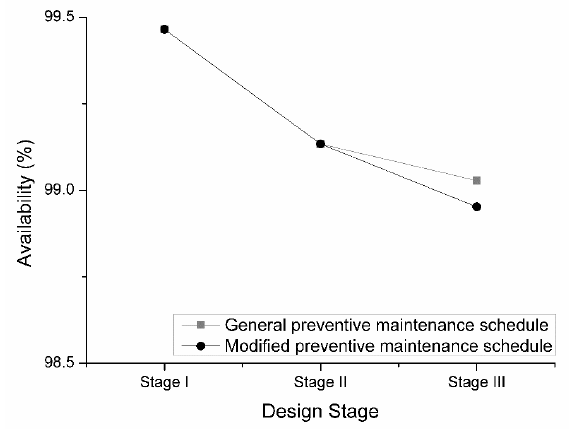
Figure 18. Availability with modified preventive maintenance schedule.